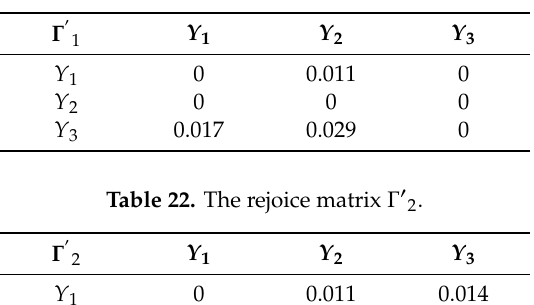
Table 21. The rejoice matrix Γ (cid:48) 1 .